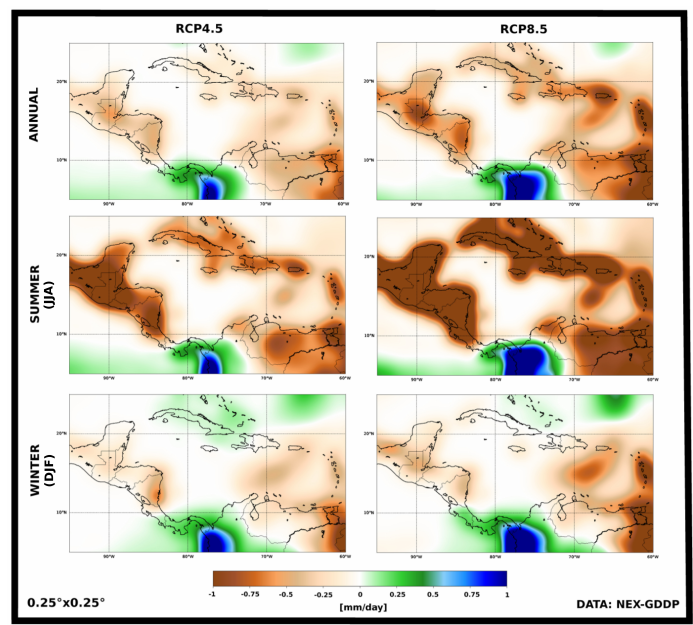
Figure 3. CMIP5 Multimodel Ensemble Mean change in precipitation (mm/day) for 2070–2099 minus 1970–1999 for RCP 4.5 and 8.5 scenarios.